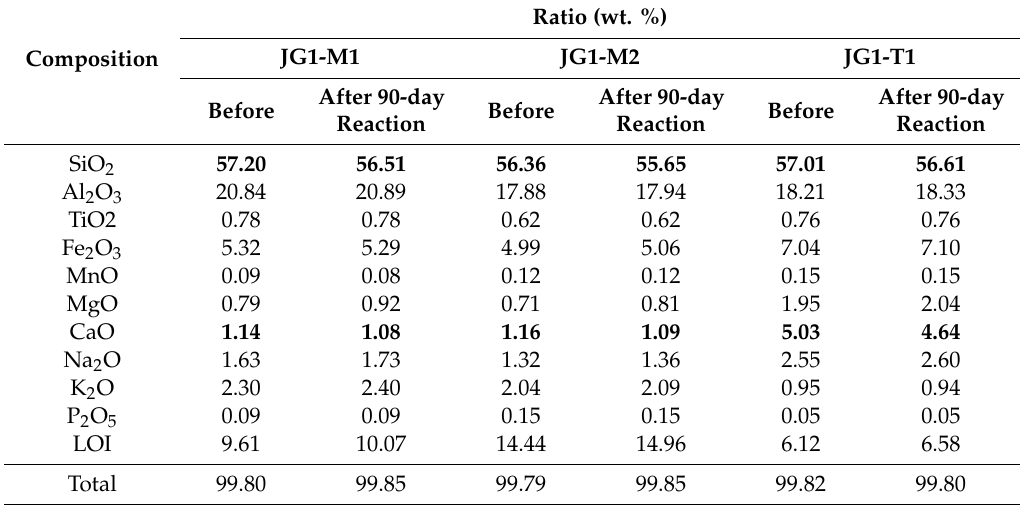
Table4. XRFanalysisofmudstoneanddacitictu ff beforeandafter90daysofscCO 2 –water–rockreaction.